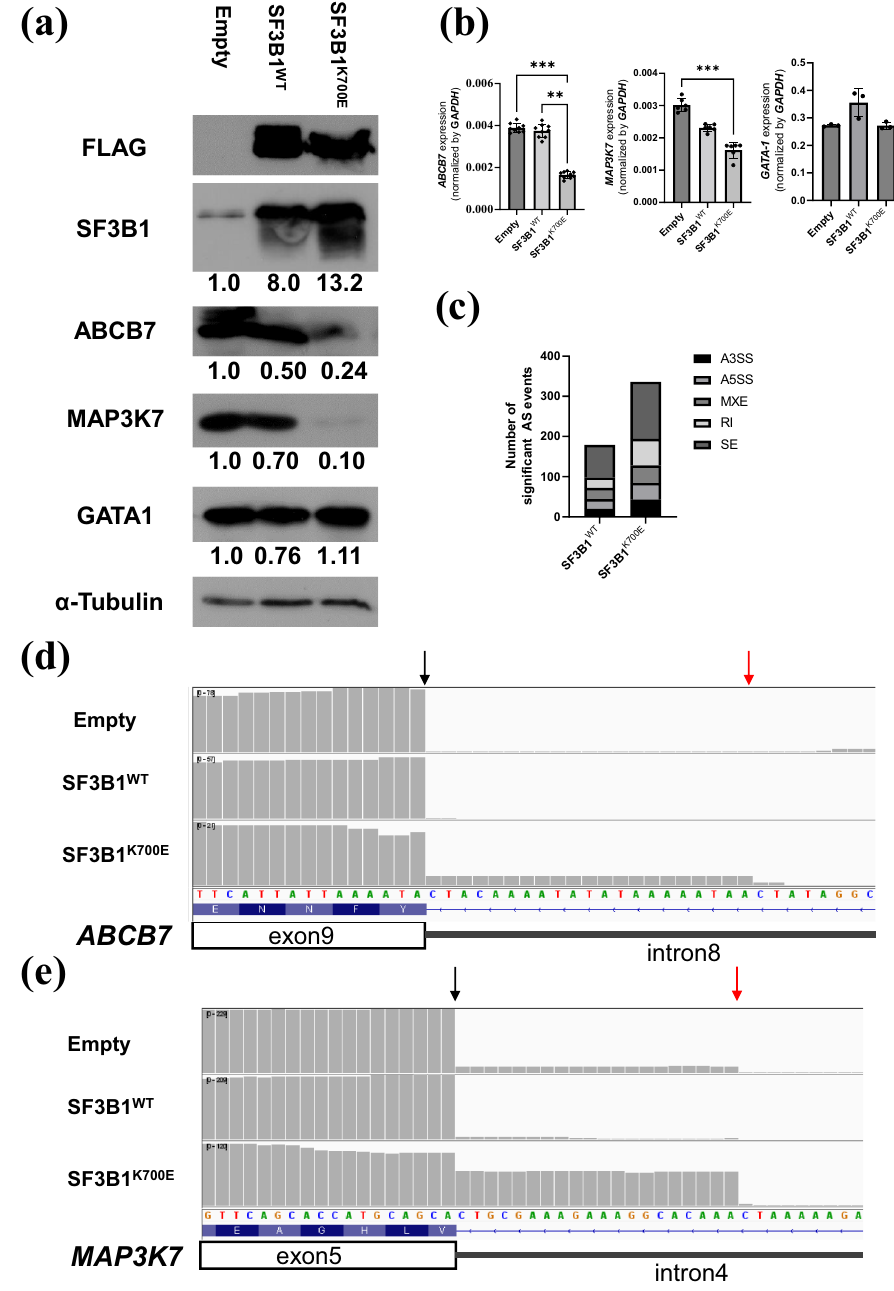
Figure 4. Gene expression analysis of K562 cells overexpressing SF3B1 K700E . ( a ) Western blot analysis for FLAG, SF3B1, ABCB7, MAP3K7, ALAS2, and GATA-1. Relative expression level of each gene in K562 cells expressing SF3B1 WT or SF3B1 K700E in comparison to control vector-transduced K562 cells are described under each picture. α-Tubulin was used as a loading control. The image of each protein was cropped from the different fields of the film. The original film is presented in Supplementary Fig. S17–21 online. ( b ) Expression levels of ABCB7, MAP3K7 and GATA-1 by quantitative RT-PCR (results shown as mean ± SD and dot plots); ** p < 0.01, *** p < 0.001. ( c ) Comprehensive AS analysis with MISO. The graph shows the number of significant AS events detected in K562 cells stably expressing SF3B1 WT or SF3B1 K700E when compared with control vector-transduced K562 cells. ( d , e ) Read-coverage visualized by IGV around canonical 3 ′ SS of ABCB7 exon 9 ( d ) and canonical 3 ′ SS of MAP3K7 exon 5 ( e ). Black and red arrow indicate canonical and aberrant 3 ′ SS, respectively. Empty, SF3B1 WT and SF3B1 K700E indicate K562 cells transduced with control vector, K562 cells overexpressing SF3B1 WT and K562 cells overexpressing SF3B1 K700E ,